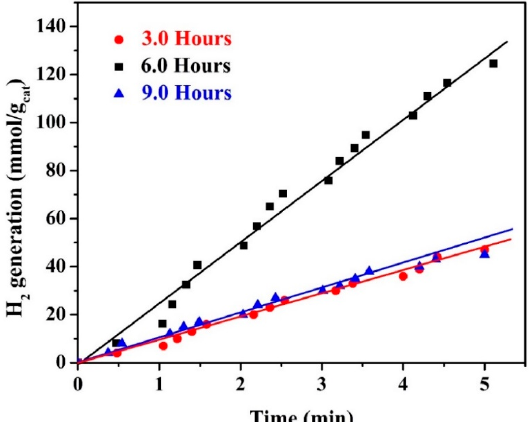
Figure 12. Influence of the hydrothermal treatment time on the hydrogen production rate from water splitting under visible light radiation; KOH concentration of 1.0 M, hydrothermal temperature of 150 °C, and calcination temperature of 800 °C.